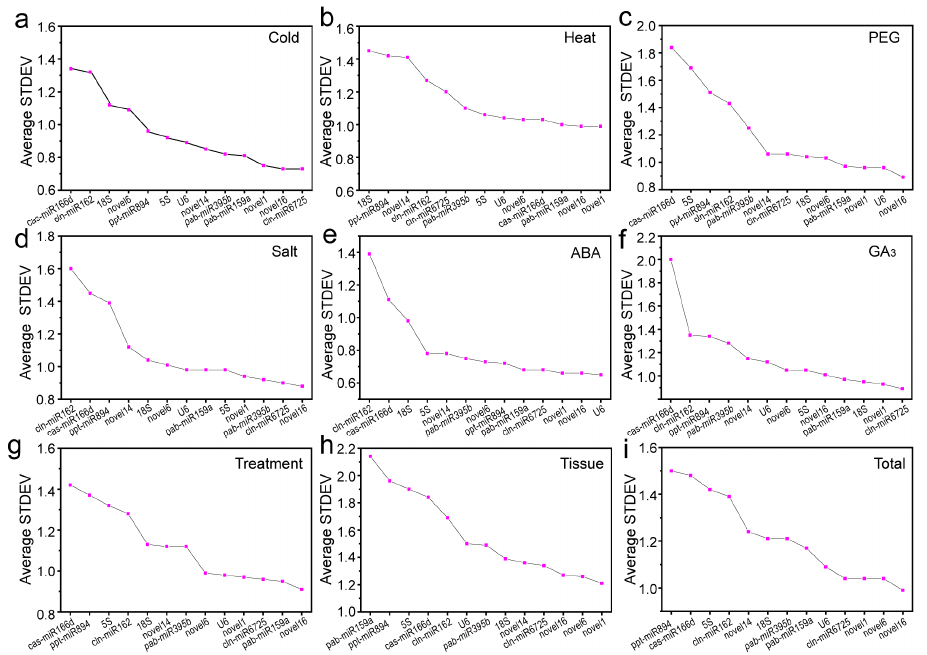
Figure 3. Average standard deviation (STDEV) by delta Ct analysis. Results from ( a ) 4 °C cold stress; ( b ) 40 °C heat stress; ( c ) drought stress simulated by 15% PEG-6000 treatment; ( d ) salt stress stimulated by 200 mM NaCl treatment; ( e ) 200 μ M ABA treatment; ( f ) 200 μ M GA 3 treatment; ( g ) multiple stresses; ( h ) different tissues (roots, stems, tender needles, cones and seeds); ( i ) total sam- ples.